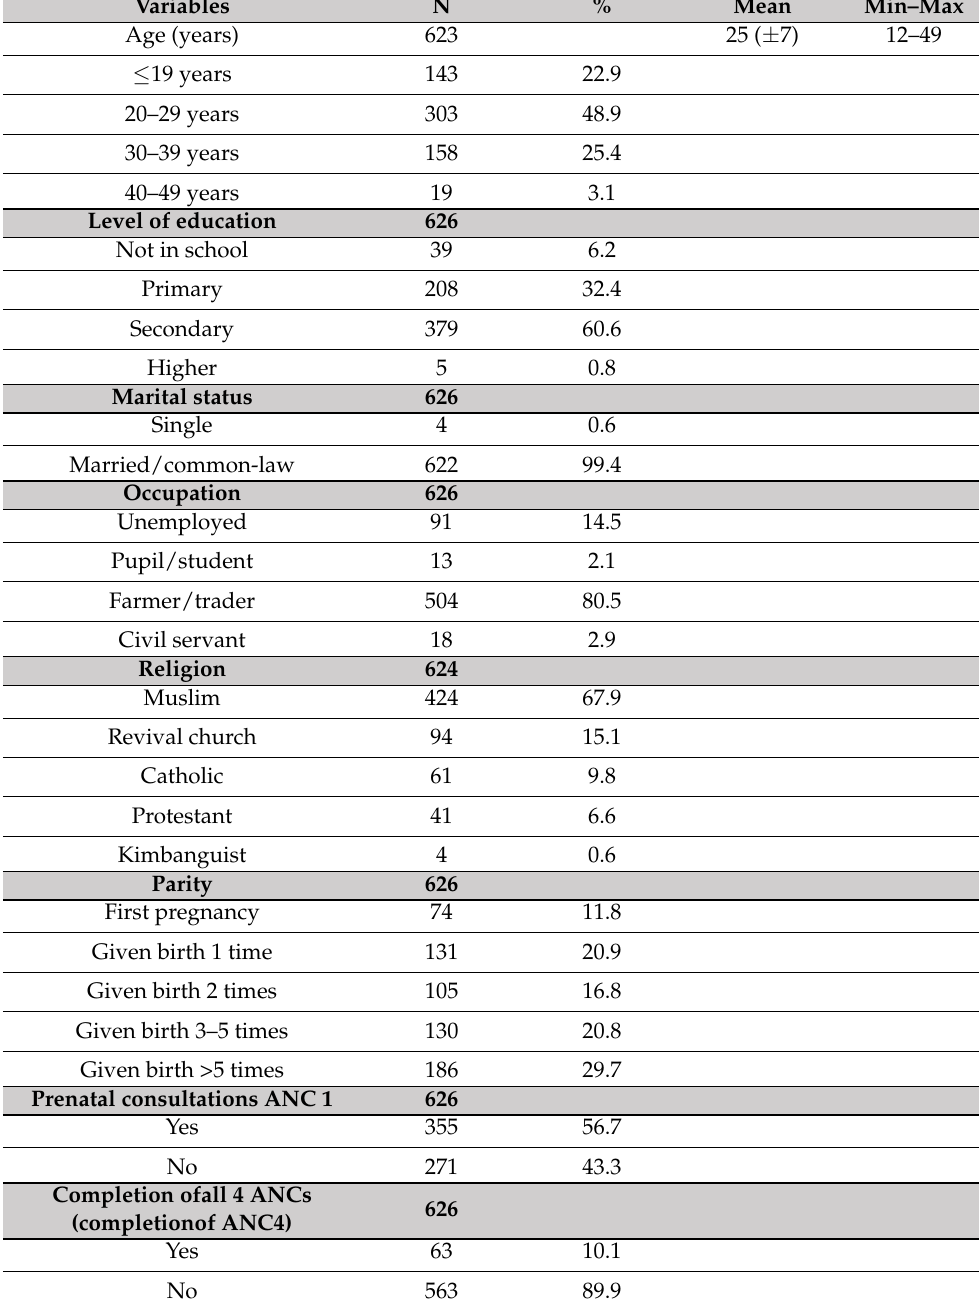
Table 3. Sociodemographic and clinical characteristics of respondents.